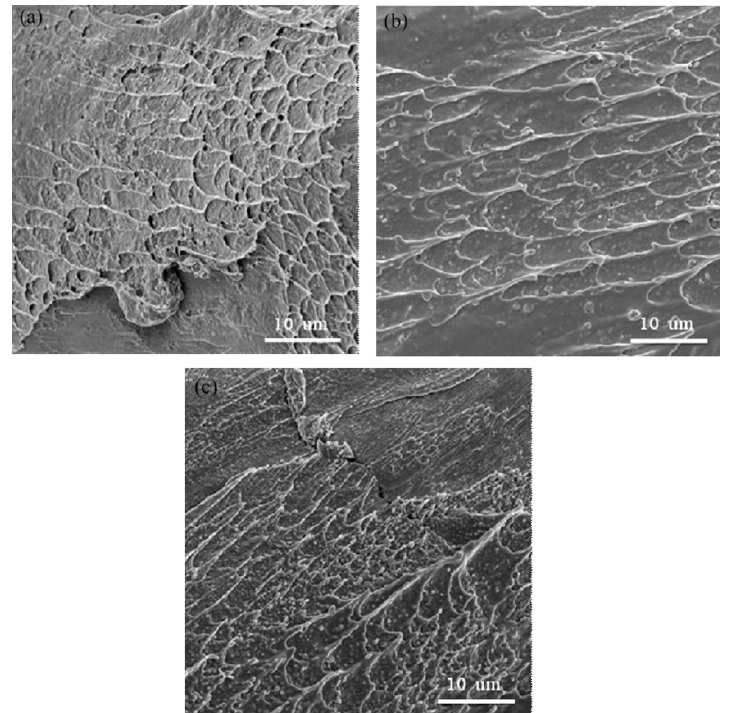
Figure 6. SEM fracture surface of Zr-based metallic glass specimens deformed at strain rates of ( a ) 10 − 3 s − 1 ; ( b ) 10 − 2 s − 1 ; and ( c ) 10 − 1 s − 1 .